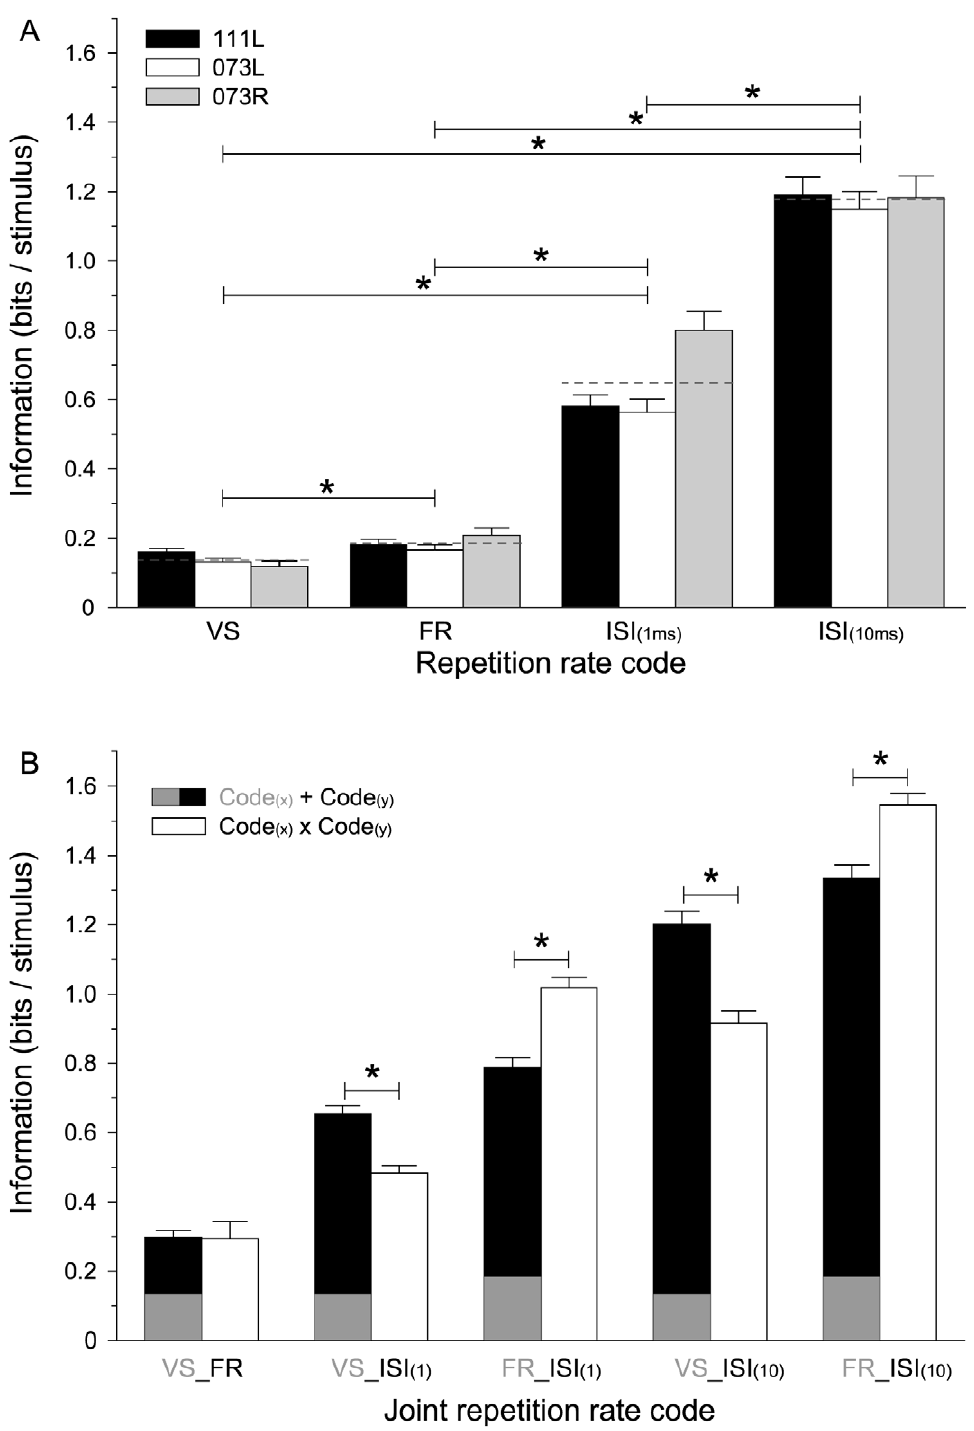
Figure 2. Mutual information (MI) contained in VS, FR, and ISI. (A) Mean ( 6 standard error of the mean) of MI values for VS, FR, ISI (1 ms) and ISI (10 ms) for all three hemispheres. The global mean is indicated as a dashed line across the three hemispheres. MI for ISI (10 ms) was based on intervals equal or larger than 10 ms, whereas MI for ISI (1 ms) contained all intervals equal or larger than 1 ms. Paired t tests adjusted by the sequential Bonferroni correction for multiple comparisons ( p , 0.001) were performed for the three global mean measures. A theoretical MI value for distinguishing six different repetition rate stimuli is 2.58 bits/stimulus (=log 2 (6)). (B) Information captured for different combinations of a joint repetition rate code. Black/gray bars: additive combination of the two codes (Code (x) + Code (y) ). The number of sites that resulted in valid joint information value was lower than the total number of sites for the individual information analysis. The summed information is based on recording sites that had a valid joint information. White bars: joint information values for two codes (Code (x) 6 Code (y) ). Unpaired t tests for the comparison between additive and joint codes ( p , 0.001).